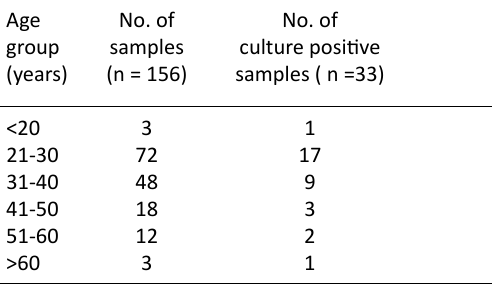
table 1. Age wise distribution of cases table 2. Bacteria isolated in the present study